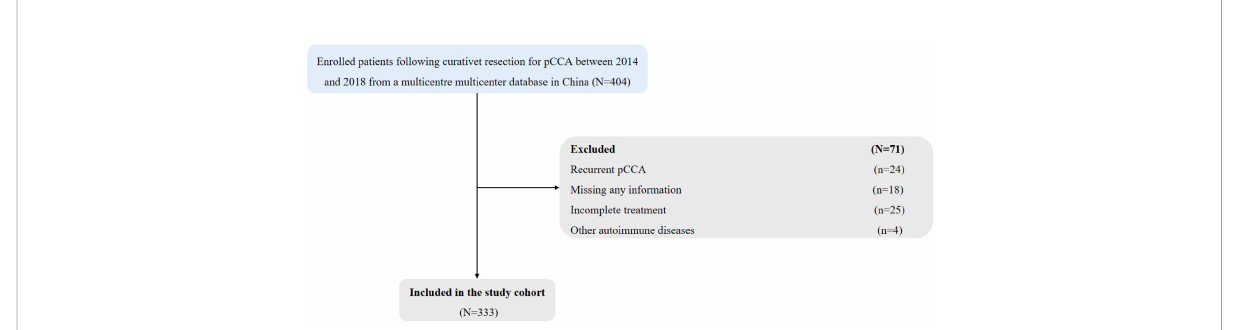
FIGURE 1 Flow chart of patient inclusion. pCCA, perihilar